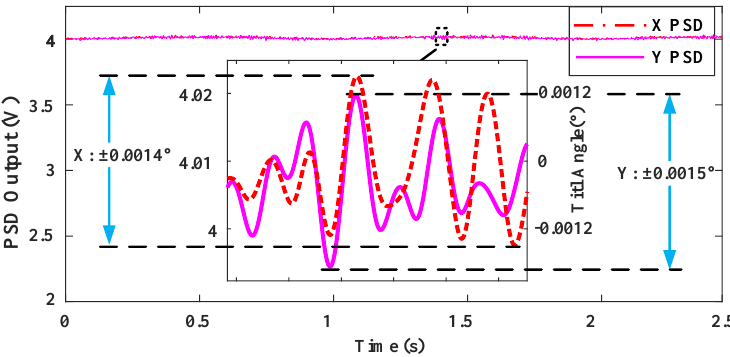
Figure 15. Measured tilt angle responses for FTS system with H∞ control.